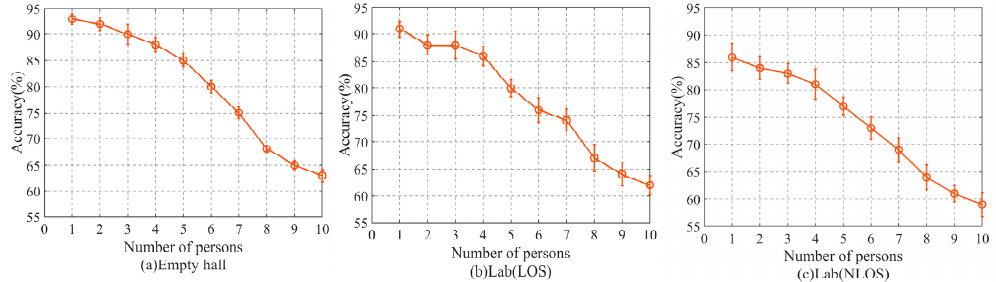
Figure 11. The influence of the number of people on the accuracy of the method. ( a ) Empty hall, ( b ) Lab (LOS), ( c ) Lab